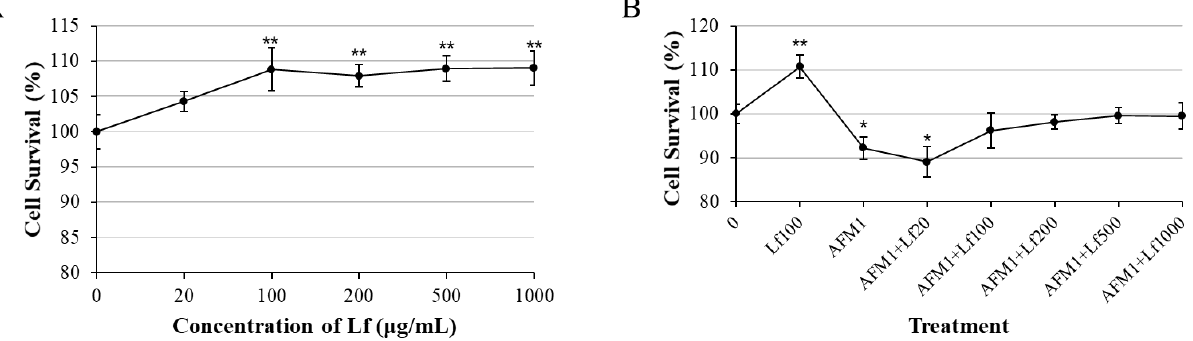
Figure 1. The effect of Lf on the proliferation of NCM460 cells. We examined the proliferation effects after NCM460 cells incubated with Lf ( A ) and together with 8 μg/mL AFM1 ( B ) for 24 h. Results represented as means ± SD. * p < 0.05, ** p < 0.01 vs. control.